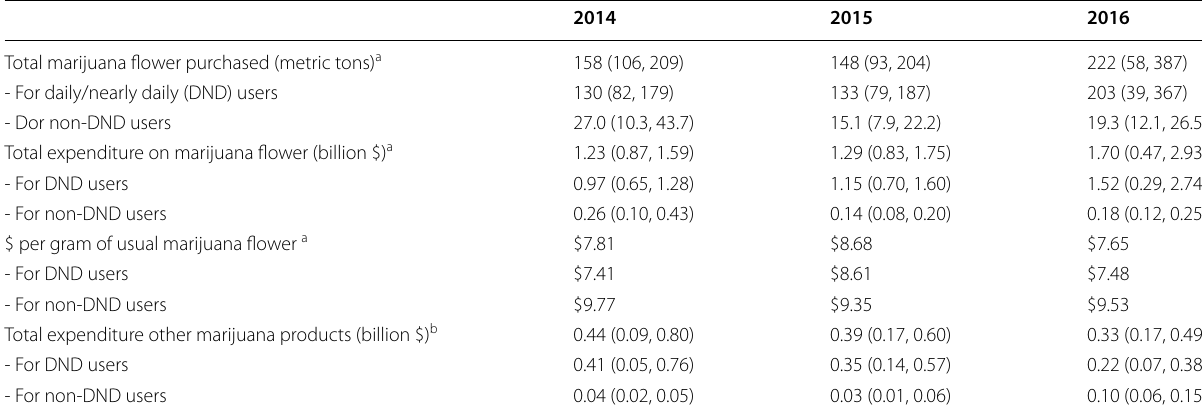
Table 3 Total market size estimates (95% CIs) for marijuana flower quantity and expenditure and for other marijuana